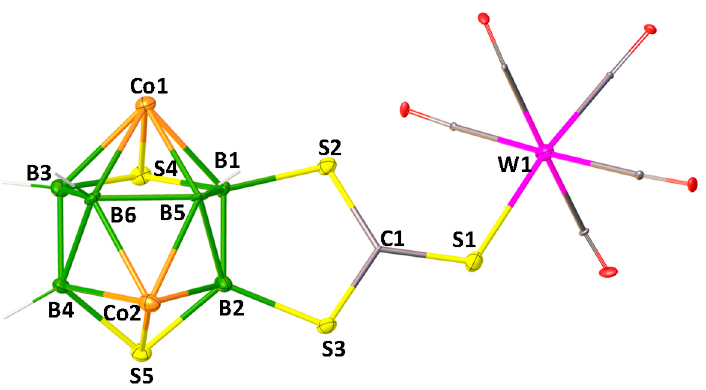
Figure 1. Molecular structure and labelling diagram of 4 (note that Cp* ligands attached to metals are omitted for clarity.) Selected bond lengths (Å) and angles (°). 4 : B1 − B2 1.790(19), W1 − S1 2.529(3), S1 − C1 1.648(12), S2 − B1 1.886(12); C1 − S1 − W1 116.3(4), C1 − S2 − B1 102.0(6).